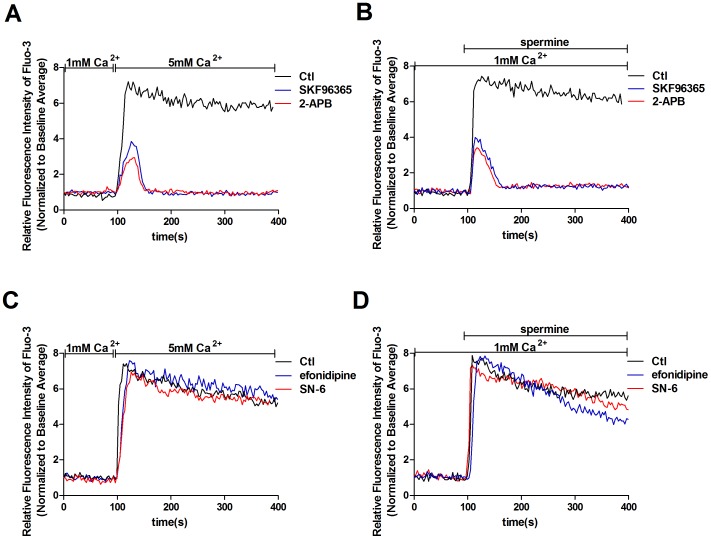
CaSR activation induces TRPC-dependent Ca2+ signaling.[Ca2+]i dynamics were monitored by Fura-3 fluorescence methods. Representative traces are shown in A–D. (A) The 5 mM [Ca2+]o-induced [Ca2+]i increase is inhibited in the presence of TRPC channel blockers (p<0.05 vs. Ctl, n = 5). Cells were pretreated with 50 µM SKF96365 or 100 µM 2-APB for 20 min in medium containing 1 mM Ca2+ followed by a change in [Ca2+]o from 1 to 5 mM. (B) In the presence of TRPC channel blockers, the 3 mM spermine-induced [Ca2+]i increase is inhibited (p<0.05 vs. Ctl, n = 5). Cells were pretreated with 50 µM SKF96365 or 100 µM 2-APB for 20 min in medium containing 1 mM Ca2+ followed by addition of 3 mM spermine. (C) Pretreatment of the cells with efonidipine (10 µM) or SN-6 (10 µM) for 20 min had no apparent effect on the 5 mM [Ca2+]o-induced [Ca2+]i signaling (p>0.05, n = 5). (D) Pretreatment of the cells with efonidipine (10 µM) or SN-6 (10 µM) for 20 min had no apparent effect on the 3 mM spermine-induced [Ca2+]i increase (p>0.05, n = 5). All other additions are indicated in the figure. The results were from at least three independent experiments, and each experiment measured 20 to 40 cells.